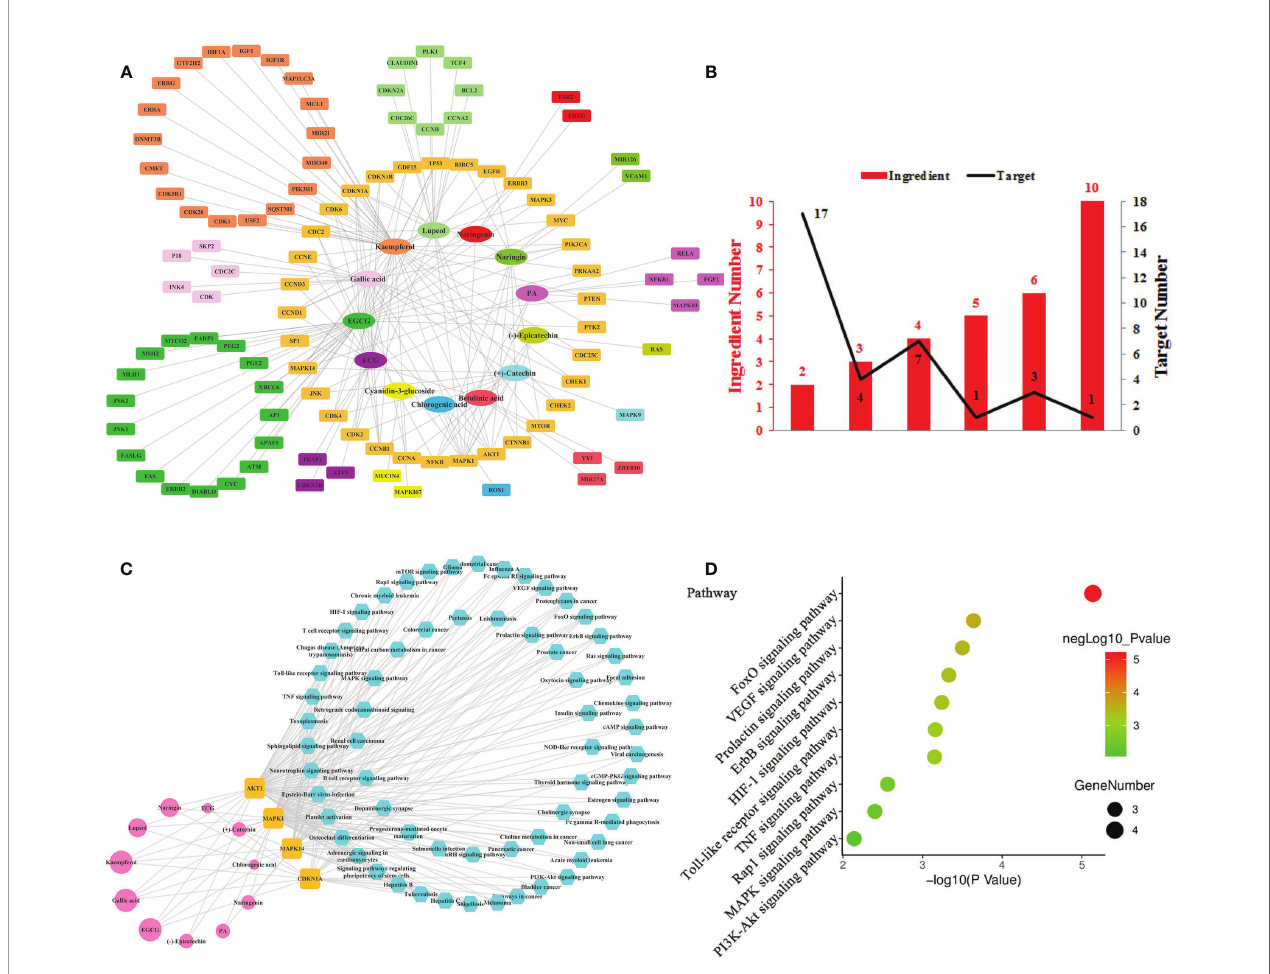
FIGURE 1 | Ingredient-Target Network of Litchi Anti-Proliferation. (A) Network of 13 ingredients (oval) and 100 corresponding targets (rectangle). (B) The histogram of “ ingredient and corresponding target number ” . (C) The ingredient-top target-signal pathway network. The round rectangle nodes (orange) correspond to 4 top targets, ellipse nodes (pink) are 11 ingredients acting on top targets, the size of the nodes is illustrated from small to big in ascending order of degree values, the hexagon nodes (blue) represent signal pathways enriched based on top targets. (D) The top 10 pathway based on KEGG enrichment